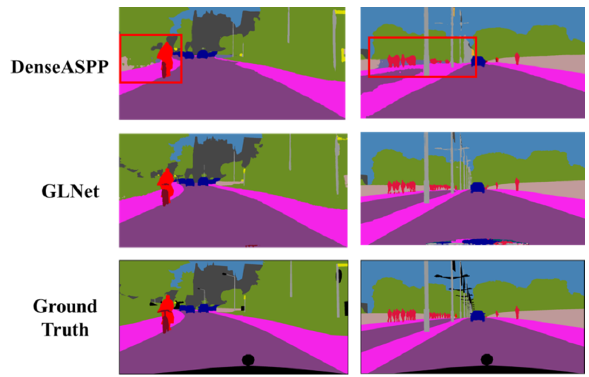
Figure 9. Visualization results of DenseASPP and GLNet on Cityscapes val. set.